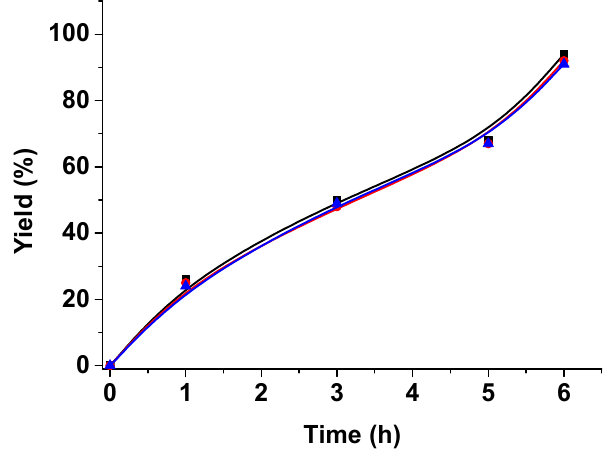
Figure 2. Temporal profile for the fresh ( ■ ), 1st reuse ( ● ) and 2nd reuse ( ▲ ) of Cu 3 (BTC) 2 during the reusability test.